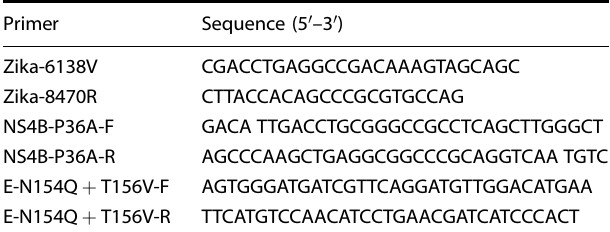
Table 2. PCR Primers used in the construction of ZE4B-36